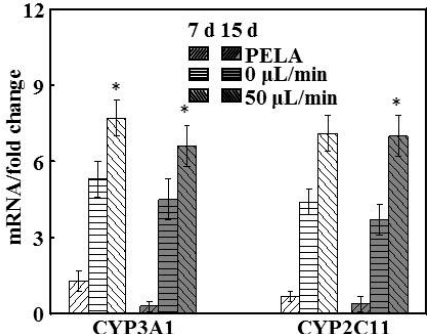
Figure 5. The mRNA levels of CYP3A1, and CYP2C11, normalized to that of β -actin, of hepatocytes for 7 and 15 days ( n = 5, * p < 0.05).